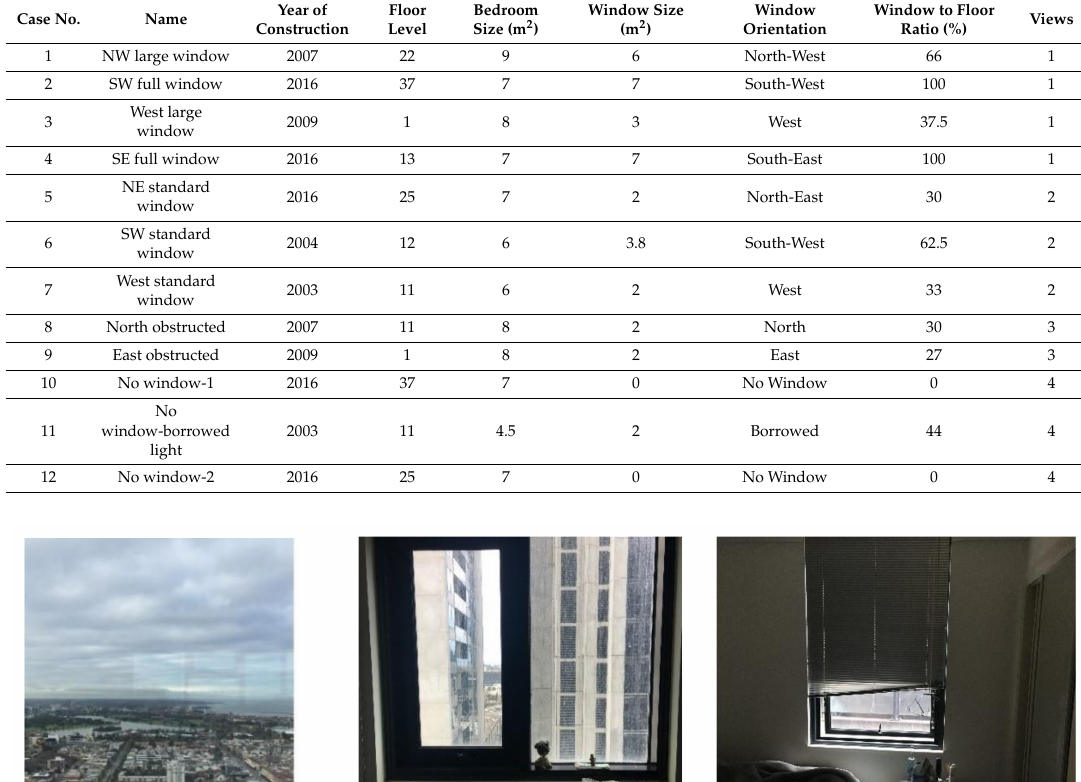
Table 1. Details of the apartment units.